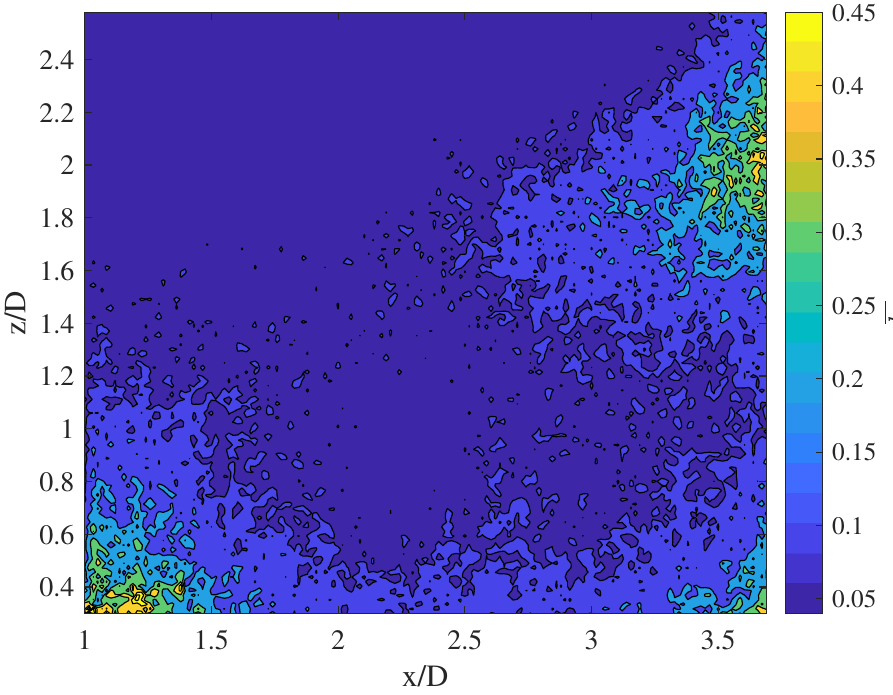
Figure 17. An example of the temporally averaged